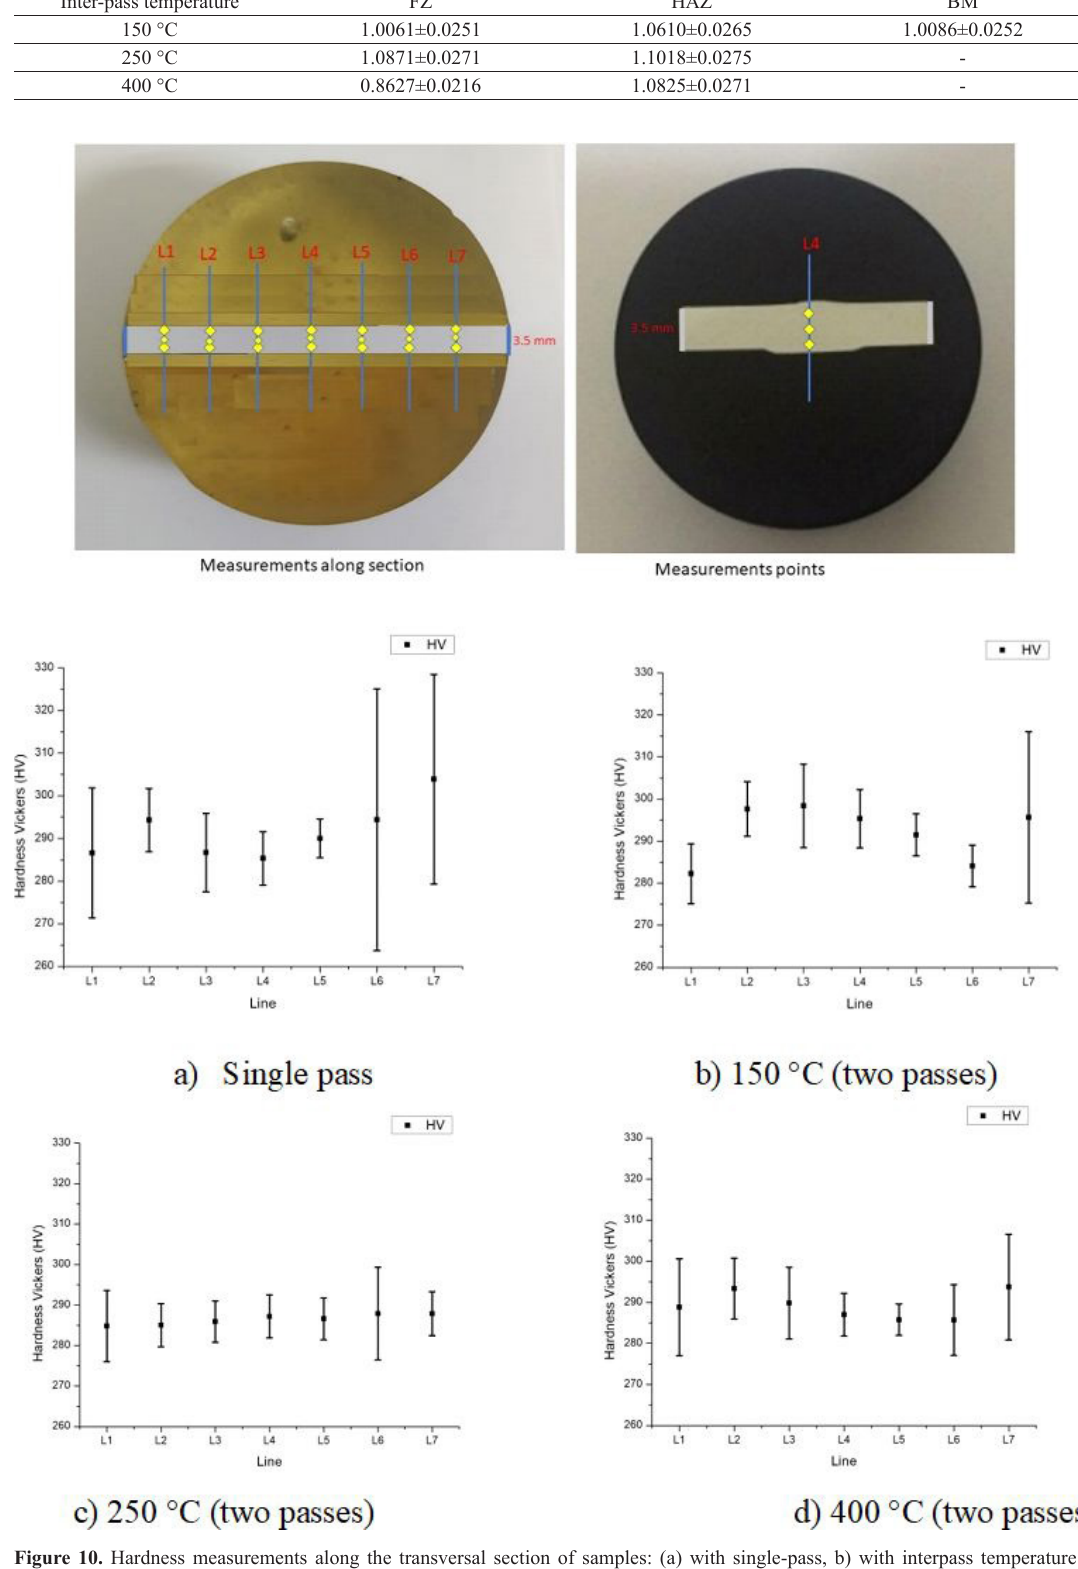
Figure 10. Hardness measurements along the transversal section of samples: (a) with single-pass, b) with interpass temperature at 150 °C; c) with interpass temperature at 250 °C, d) with interpass temperature at 400